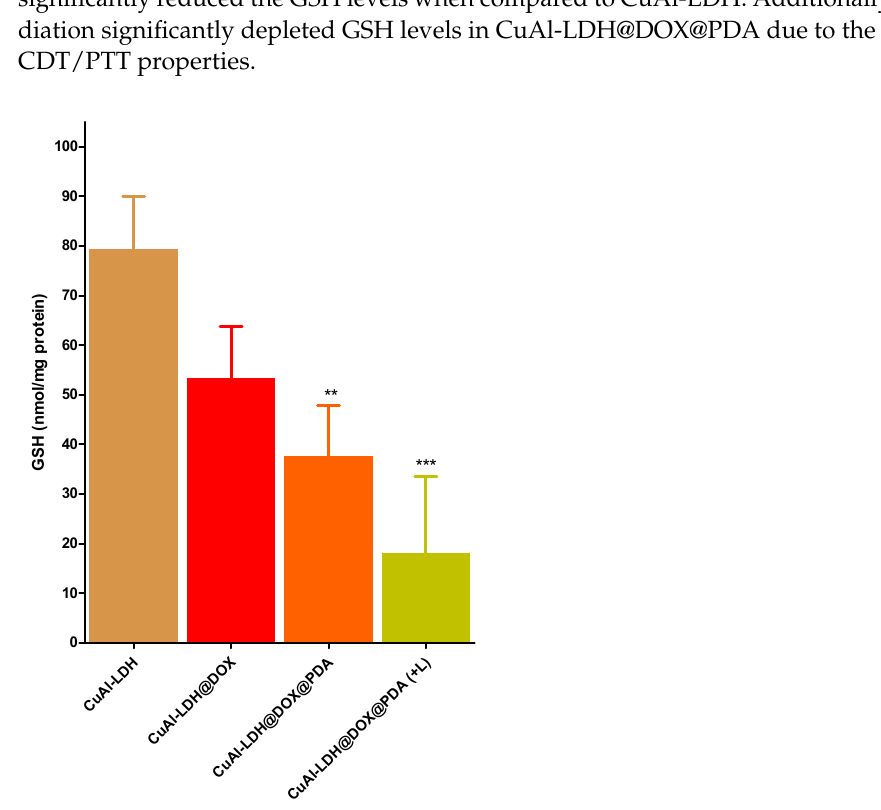
Figure 7. NCs inhibits GSH production in A549 cells. Different NCs inhibit GSH production in A549 cells compared with 0 µM of the treatment group. ** and *** denotes the significant differences of CuAl-LDH@DOX@PDA, CuAl-LDH@DOX@PDA (+L) compared with 0 µM of NC.